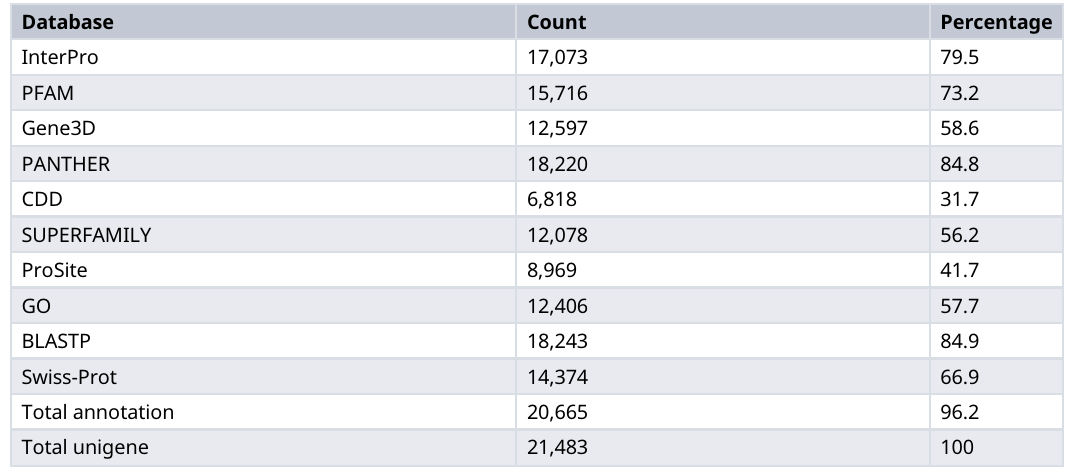
Table 7. Functional